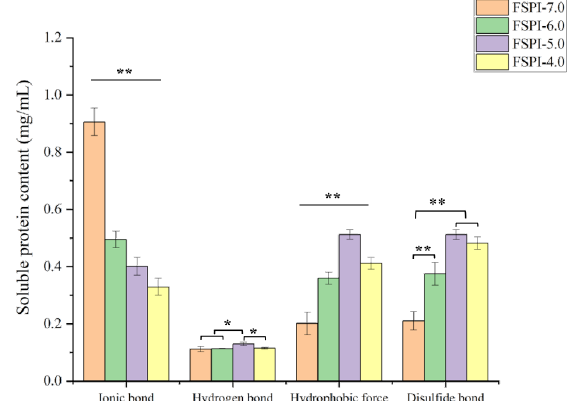
Figure 2. Interaction (ionic bond, hydrogen bond, and hydrophobic forces) between proteins of FSPI at varied levels of terminal pH. Analysis of variance level, * p < 0.05, ** p < 0.01.